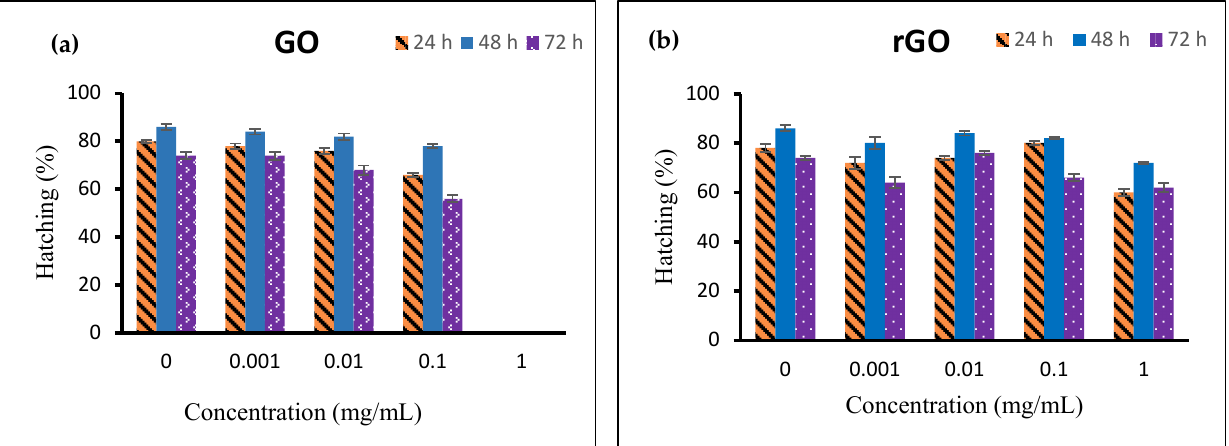
Figure 10. Percentage of hatched A. salina cysts incubated in different concentrations of ( a ) GO and ( b ) rGO.